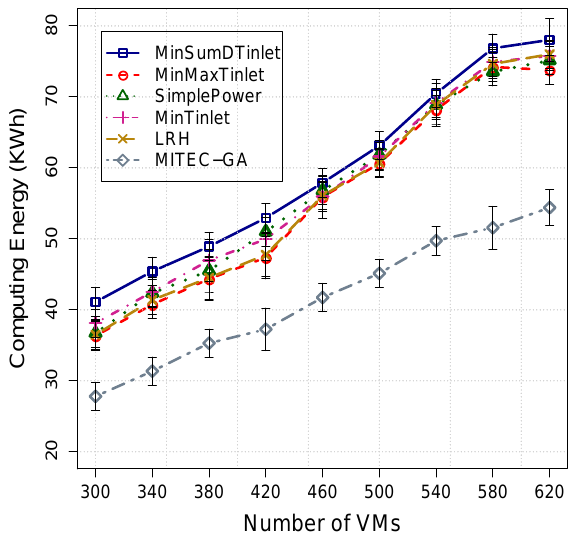
Figure 3. Computing energy consumption vs. VM